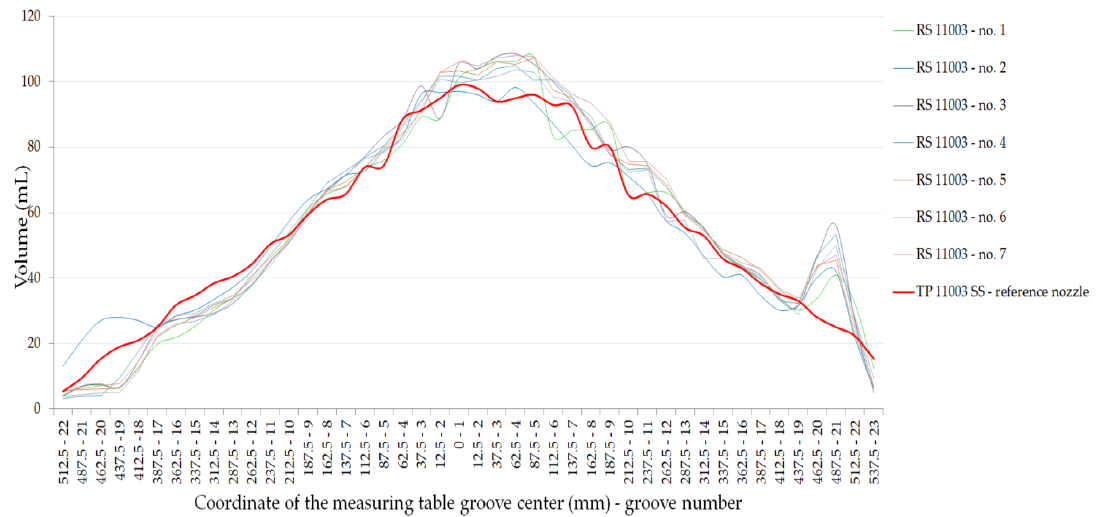
Figure 4. Volume distribution for the RS11003 nozzles and the reference TP11003-SS nozzle. Table 2. Test results for RS11003 nozzles and TP11003-S reference nozzle.